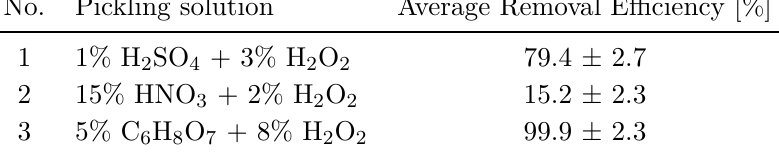
Table 8. Cleaning procedure investigation to remove radon daughters on copper surface [21].